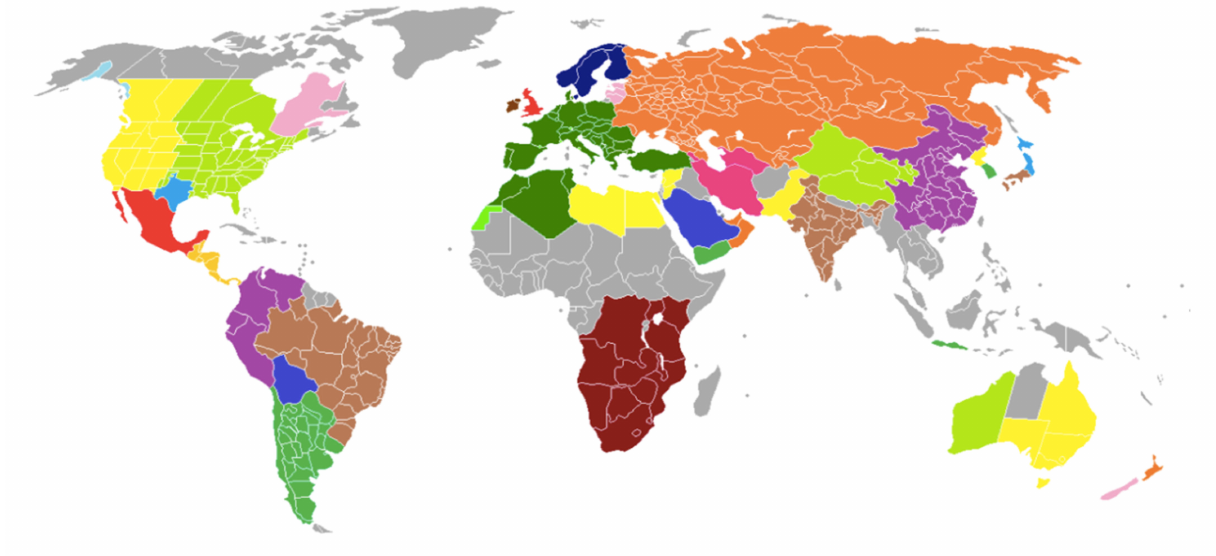
Figure 2. Map of synchronous electricity grids in different parts of the world [12]. Map of synchronous grids by Alinor is licensed under CC BY-SA